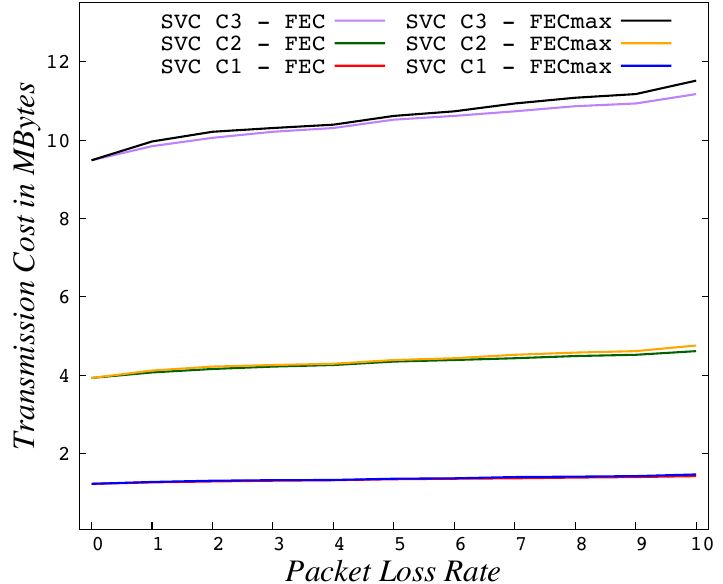
Figure A1. Transmission cost for the SVC-SC classes C1, C2 and C3 for both LR max and LR max packet loss rates from 0 to 10%.